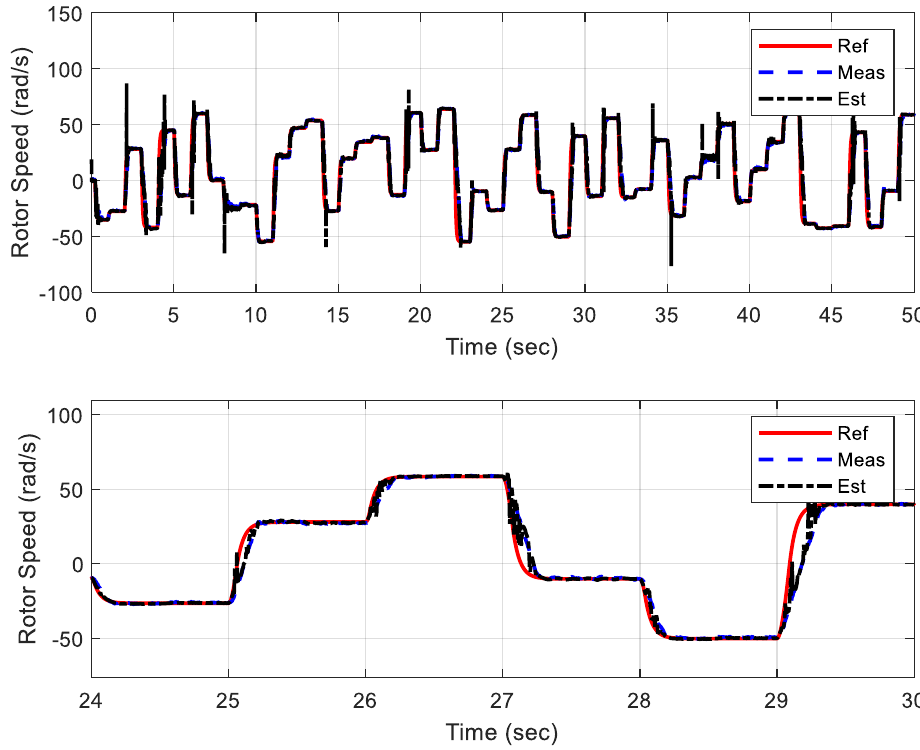
Figure 15. Dynamic performance of reference measured and estimated speeds.